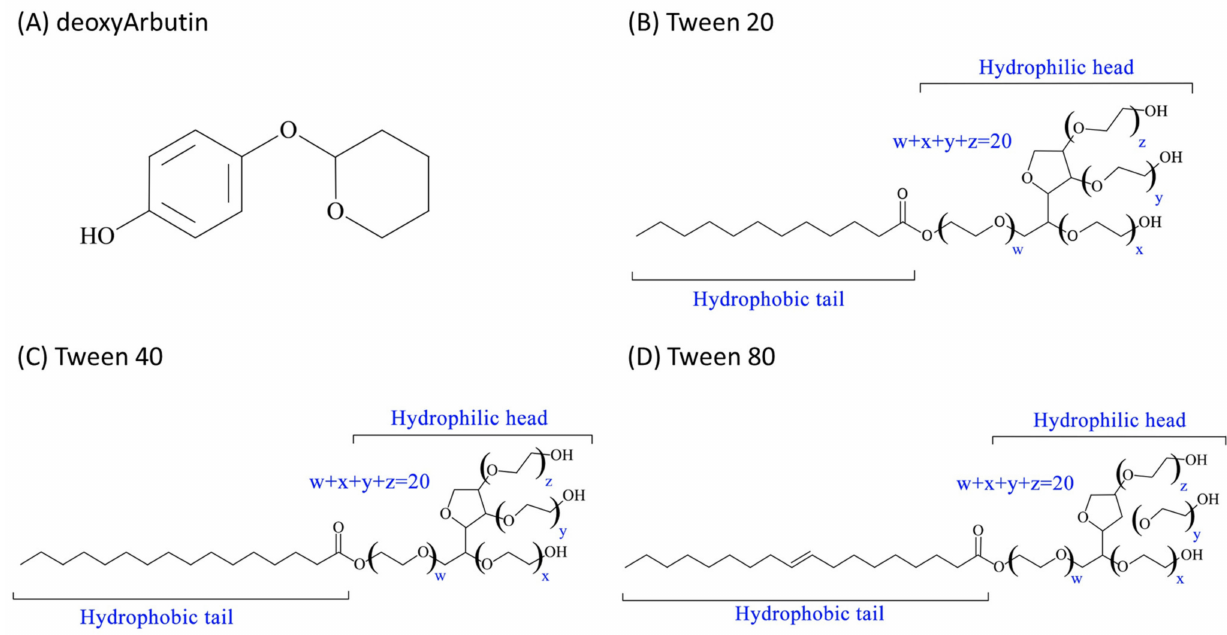
Figure 1. Chemical structures of the compounds and surfactants used: ( A ) deoxyArbutin; ( B ) Tween 20; ( C ) Tween 40; ( D ) Tween